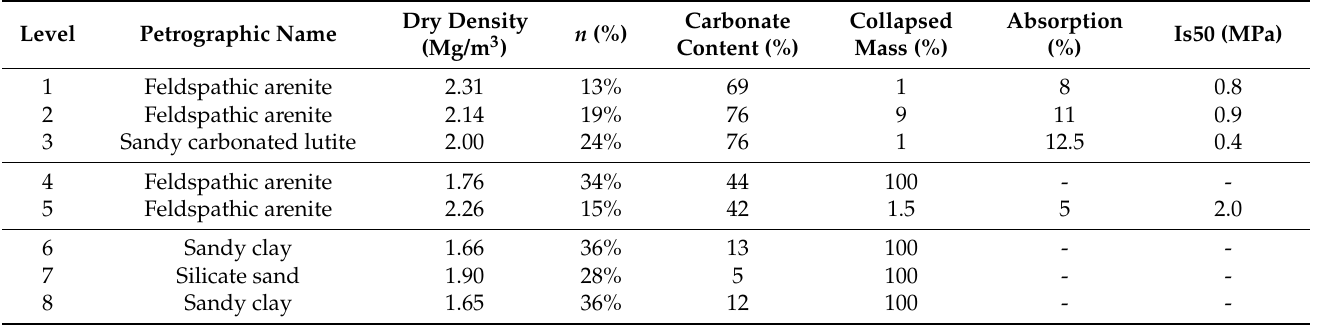
Table 3. Dry density, porosity ( n ), carbonate content (%), and collapsed mass (%) in the submerged water test. On the rock levels, results of the absorption test and (Is50) point load strength index. The petrographic name for each level is indicated.